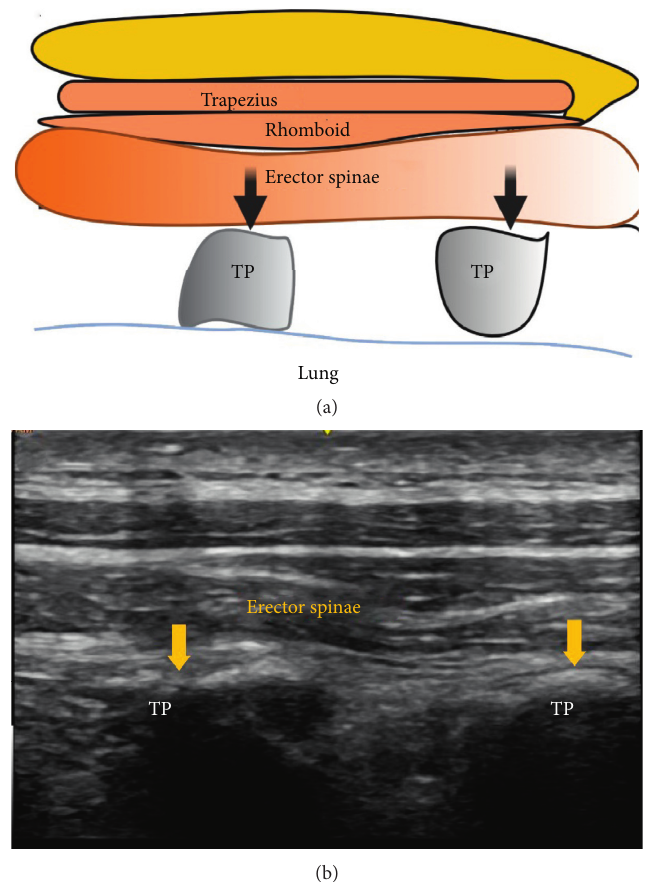
Figure 6: TP: transverse process. Black and yellow arrows indicate the point of local anaesthetic